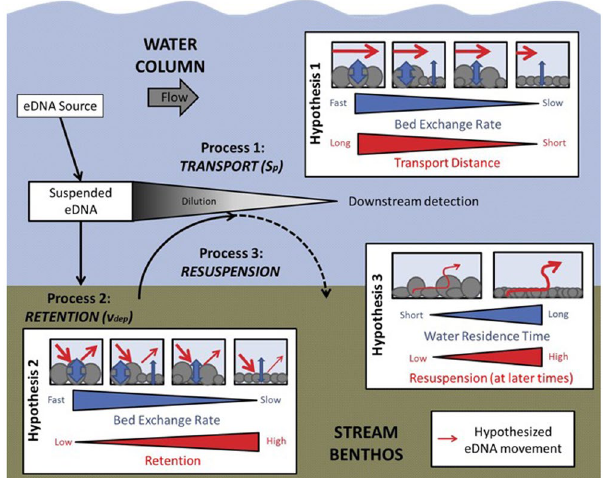
Figure 1. Conceptual diagram depicting the three governing processes of eDNA movement in streams: 1) Transport, 2) Retention, and 3) Resuspension, and associated hypotheses for eDNA